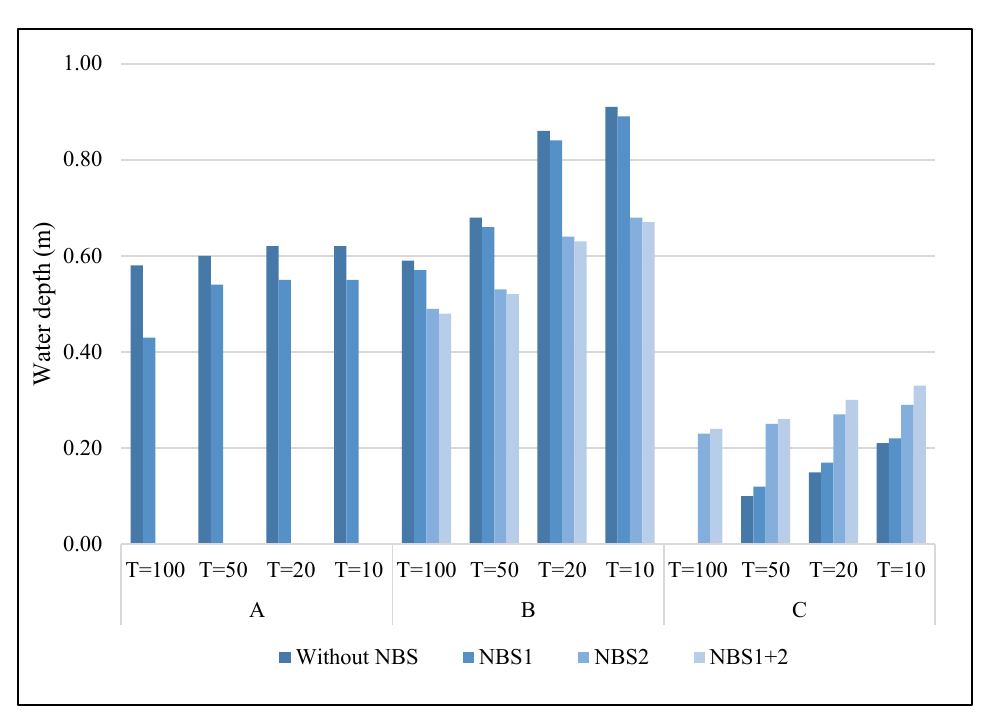
Figure 6. Mean water depth during 10–, 20–, 50– and 100–year floods for the three sites identified in Figure 5 (A, B and C) in the four simulation scenarios investigated (without NBS, and with implementation of NBS1, NBS2 and NBS1+NBS2).